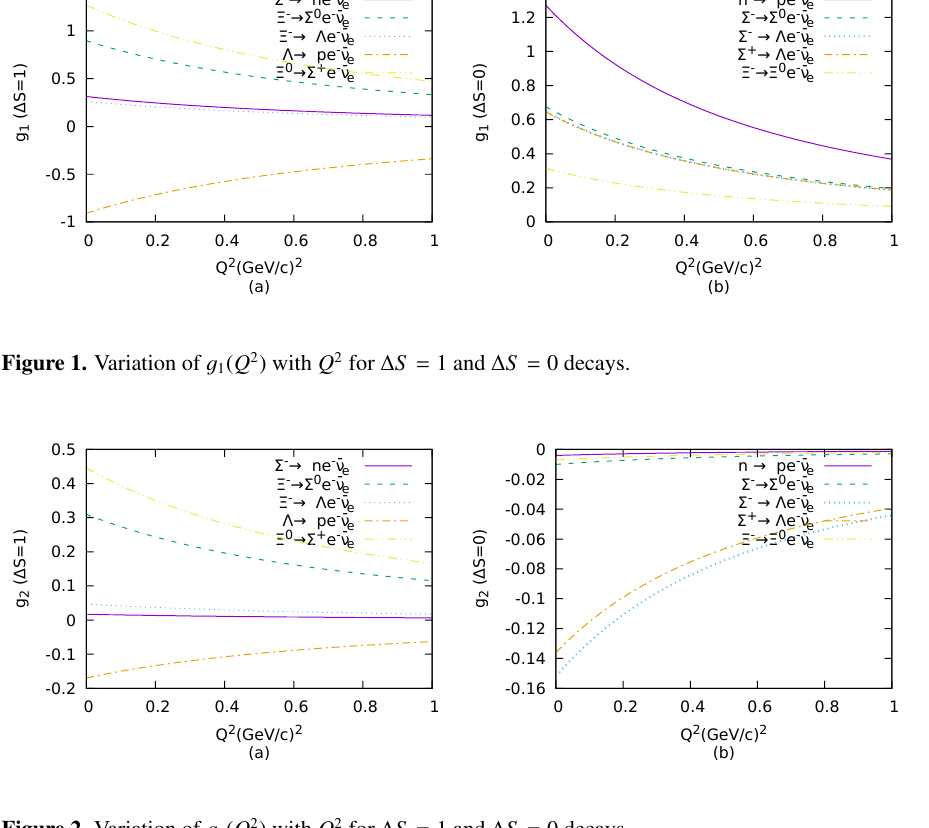
Figure 2. Variation of g 2 ( Q 2 ) with Q 2 for ∆ S = 1 and ∆ S = 0